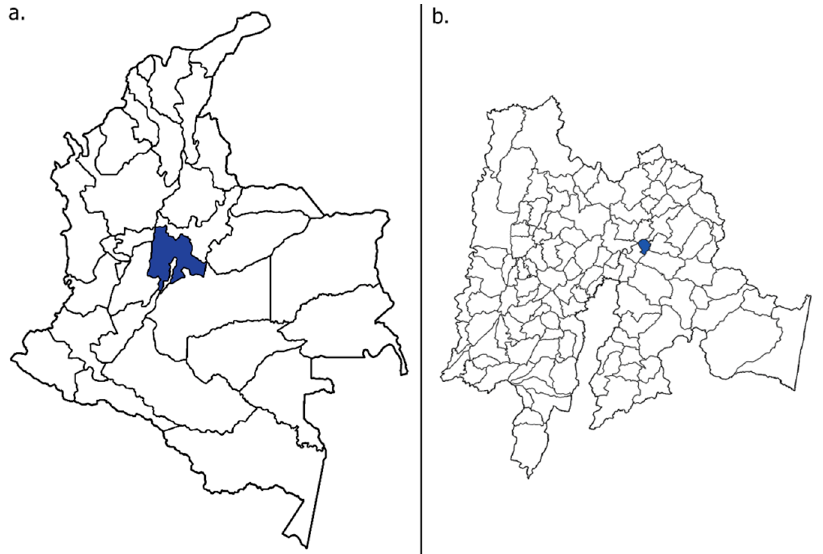
Figure 2. (a) Map of Colombia. Cundinamarca region highlighted in blue. (b) Map of Cundinamarca. Figure 2. ( a ) Map of Colombia. Cundinamarca region highlighted in blue. ( b ) Map of Cundinamarca. Gachancipá highlighted in blue. Gachancip á highlighted in